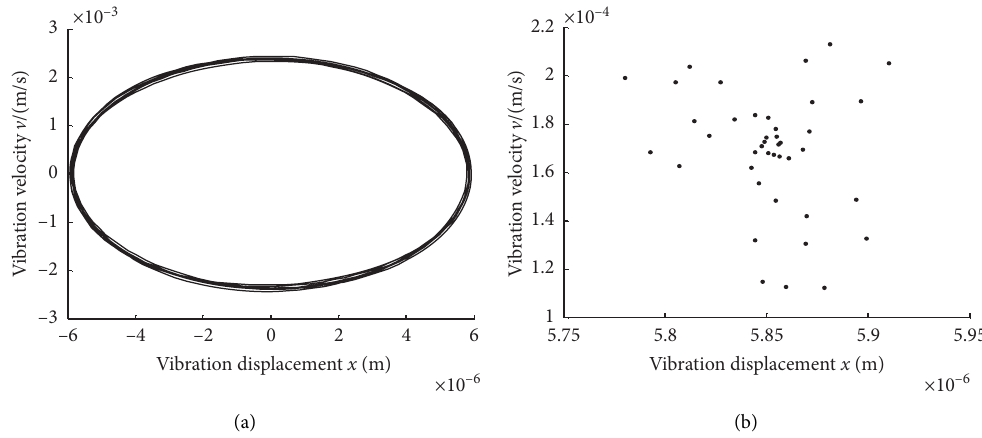
Figure 11: F � 6 . 27 × 10 5 N , chaotic motion. (a) Phase trajectory diagram. (b) Poincar´e section.